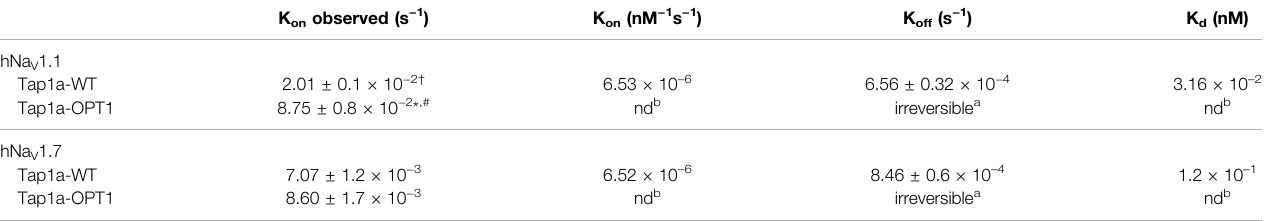
TABLE 3 | Kinetic properties of Tap1a-WT and Tap1a-OPT1 at hNa V 1.1 and hNa V 1.7 determined via patch-clamp electrophysiology. Kinetic data were determined using peptide concentrations equivalent to 10 × IC 50 , and k obs and k off are given as the mean ± SEM from 4 – 7 independent experiments. K on observed (s − 1 )